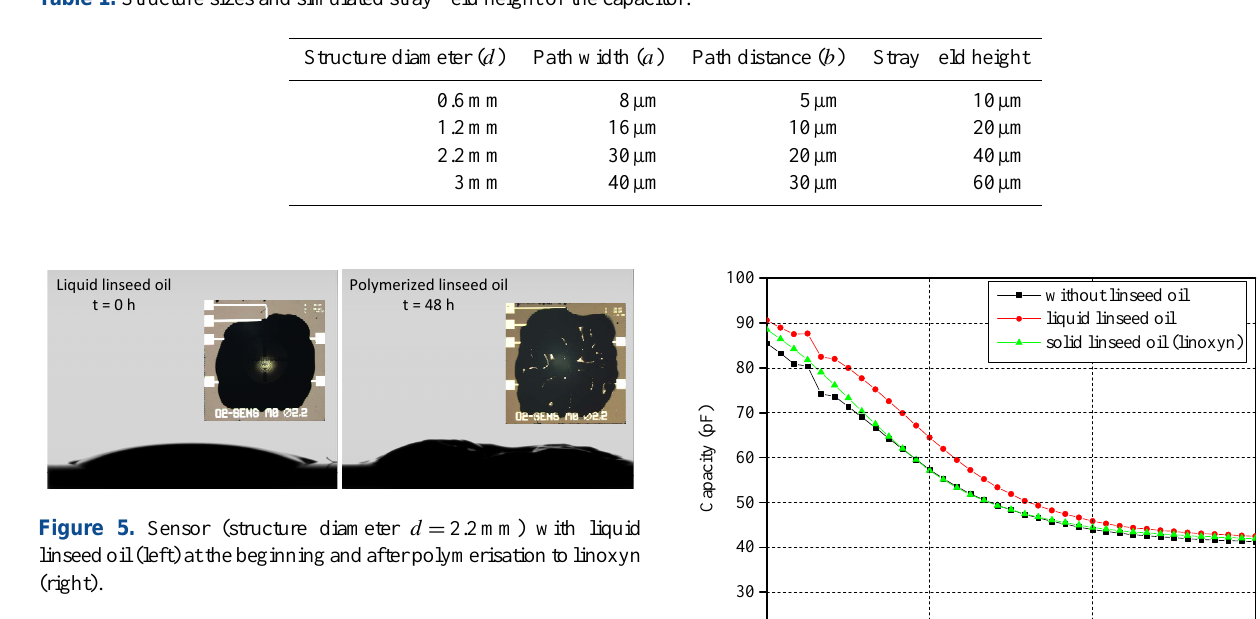
Table 1. Structure sizes and simulated stray field height of the capacitor.